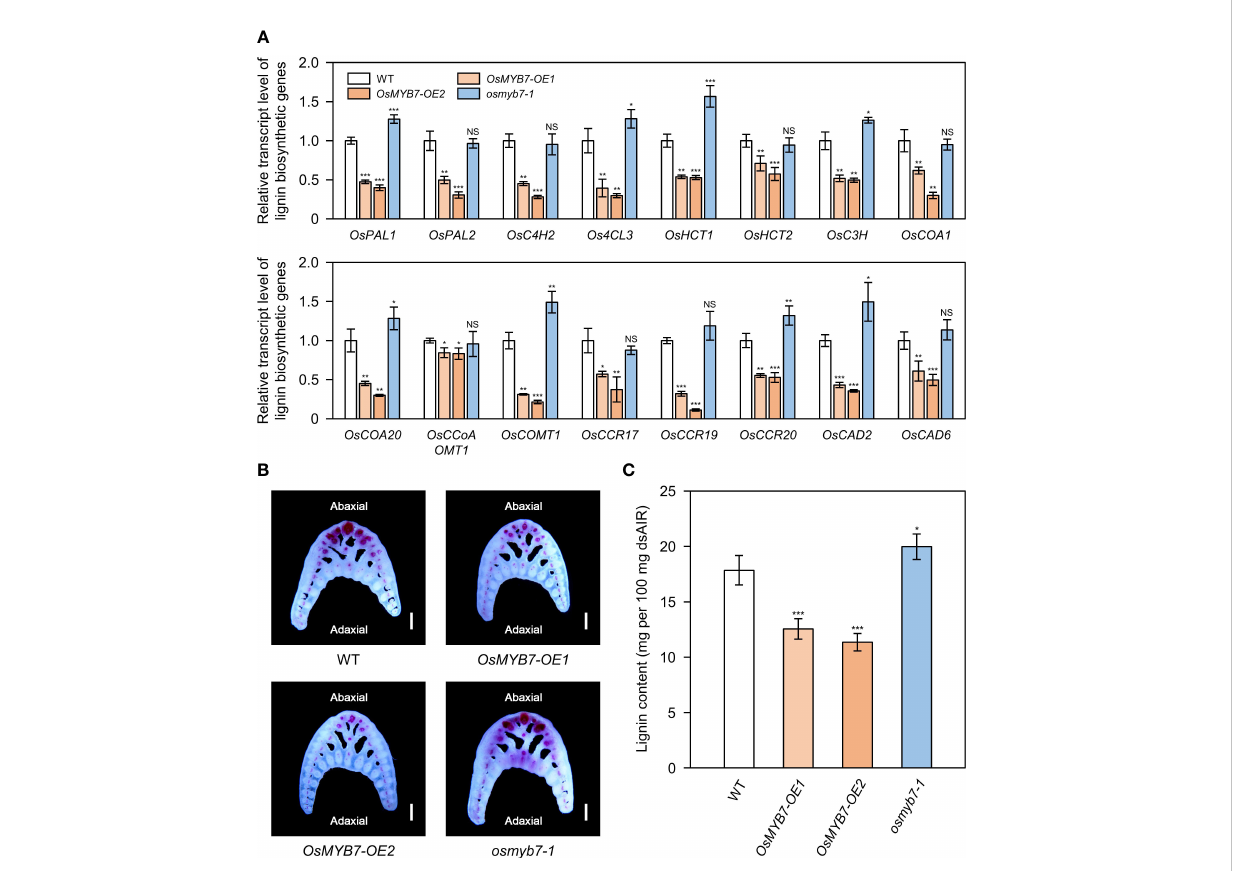
FIGURE 4 OsMYB7 negatively regulates lignin biosynthesis at the lamina joint. (A) Relative transcript levels of lignin biosynthetic genes in WT, OsMYB7-OE1 , OsMYB7-OE2 , and osmyb7-1 plants. Samples were harvested from the fl ag leaf lamina joints at the S5 stage from plants grown under natural long- day conditions in a paddy fi eld. The expression levels of each gene determined by RT-qPCR analysis were normalized to those of GAPDH and represented relative to WT, which was set to 1. Data are presented as means ± SD from four biological samples (around 30 lamina joints per sample). Asterisks indicate signi fi cant differences as determined by two-tailed Student ’ s t -test (* P < 0.05, ** P < 0.01, and *** P < 0.001). These experiments were conducted twice with similar results. NS, not signi fi cant. (B) Histochemical staining of the lamina joint for lignin. Flag leaf lamina joints of WT, OsMYB7-OE1 , OsMYB7-OE2 , and osmyb7-1 plants at the ripening stage (30 DAH) grown in a natural paddy fi eld were collected, and the corresponding transverse hand sections were subjected to phloroglucinol-HCl staining, which visualizes lignin as a pink to red color. Scale: 500 m m. Similar results were obtained in at least three independent samples. (C) Determination of lignin contents in lamina joints of WT, OsMYB7-OE1 , OsMYB7-OE2 , and osmyb7-1 plants. Lamina joints of fl ag leaves at the S5 developmental stage were collected from plants grown under natural long-day conditions and subjected to acetyl bromide assay, which quanti fi es total lignin contents. Data are presented as means ± SD from six independent samples (around 50 lamina joints per sample); asterisks indicated signi fi cant differences as determined by two-tailed Student ’ s t -test (* P < 0.05 and *** P < 0.001). These experiments were repeated twice, yielding similar results. dsAIR, destarched alcohol-insoluble cell wall